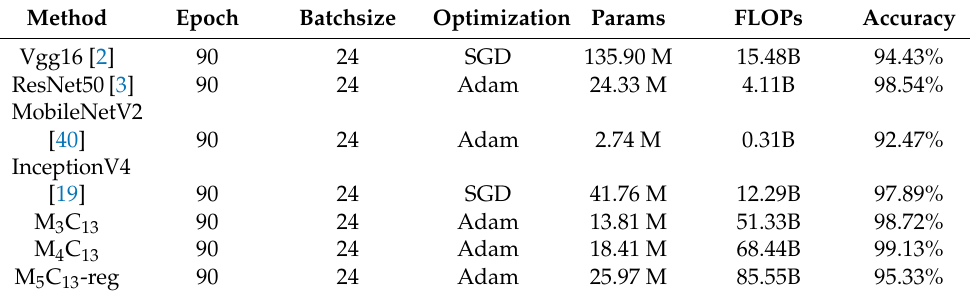
Table 5. Evaluation Results in the Birds-400 Dataset.